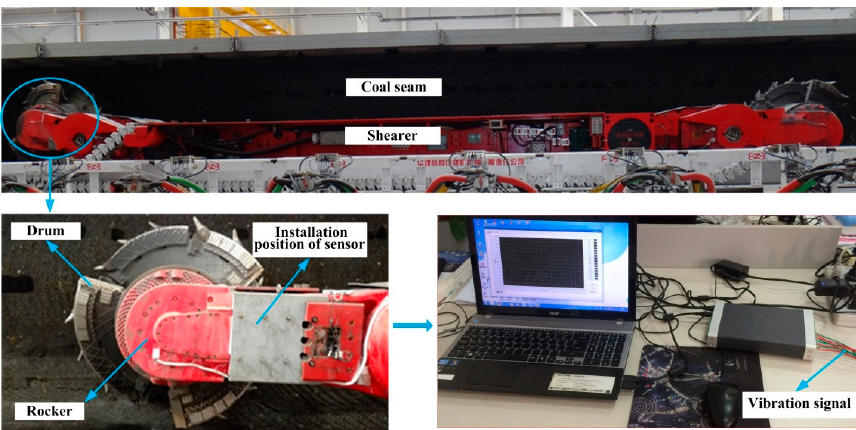
Figure 3. The self-designed experimental system for shearer cutting coal.